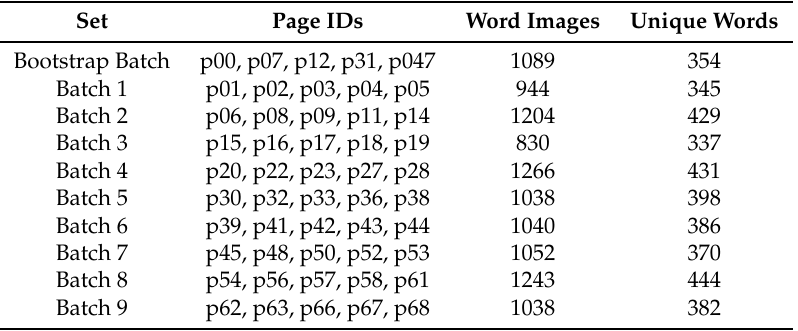
Table 1. Data set organization.